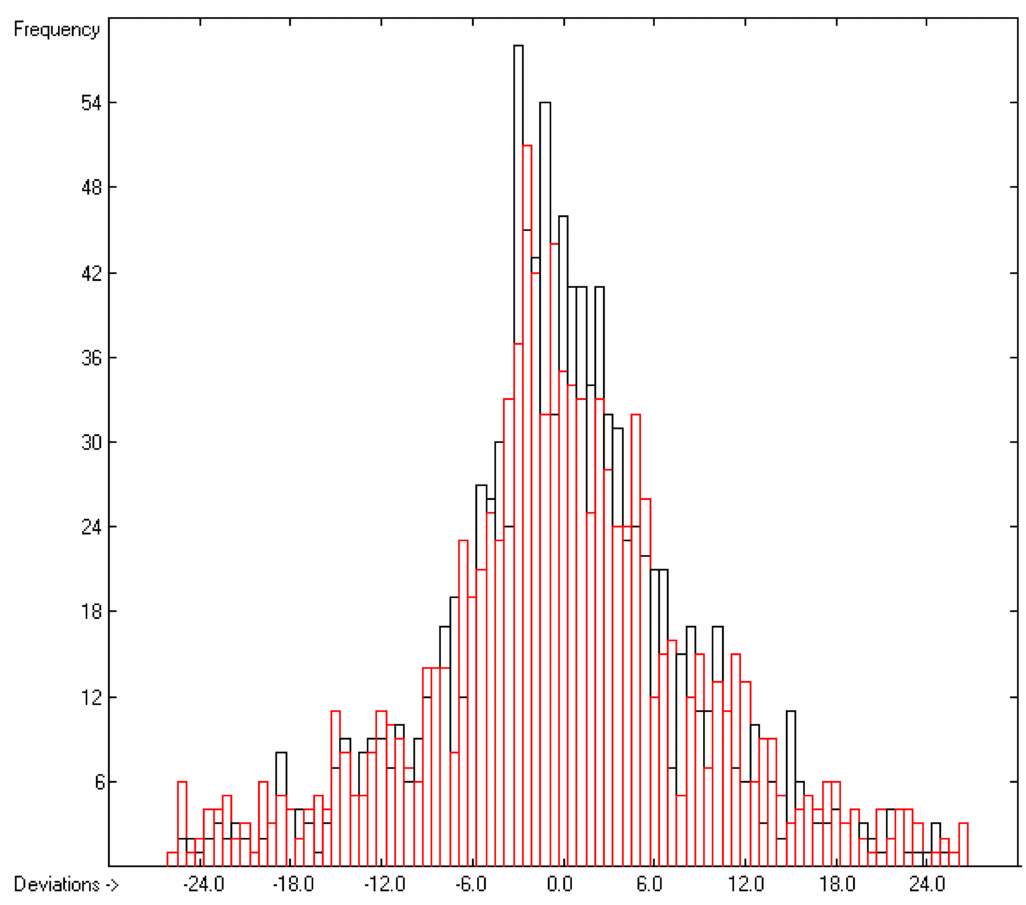
Figure 2. Histogram of the liquid heat-capacity data. The deviations are in J / mol / K. The cross-validation data are superimposed as red bars. (S = ± 9.19; Experimental value range: 81.92–1849 J / molK). Table 4. Experimental C p (liq,298) data of 66 alkanols, compared with prediction values calculated by the present the group-additivity (GA) and the V m [1] method (in J / mol /